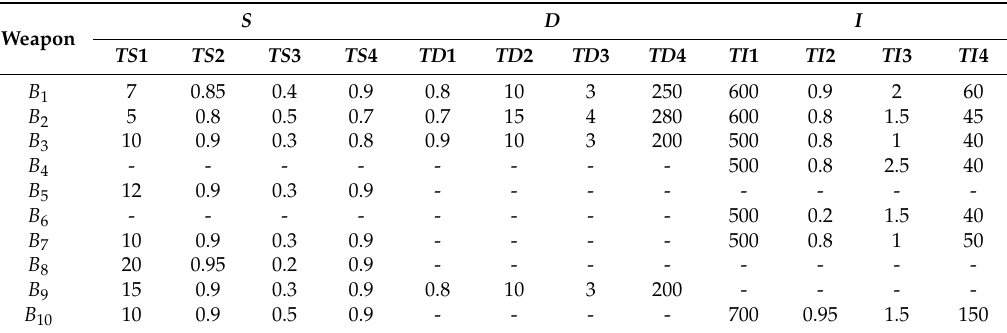
Table 3. Tactical and technical index